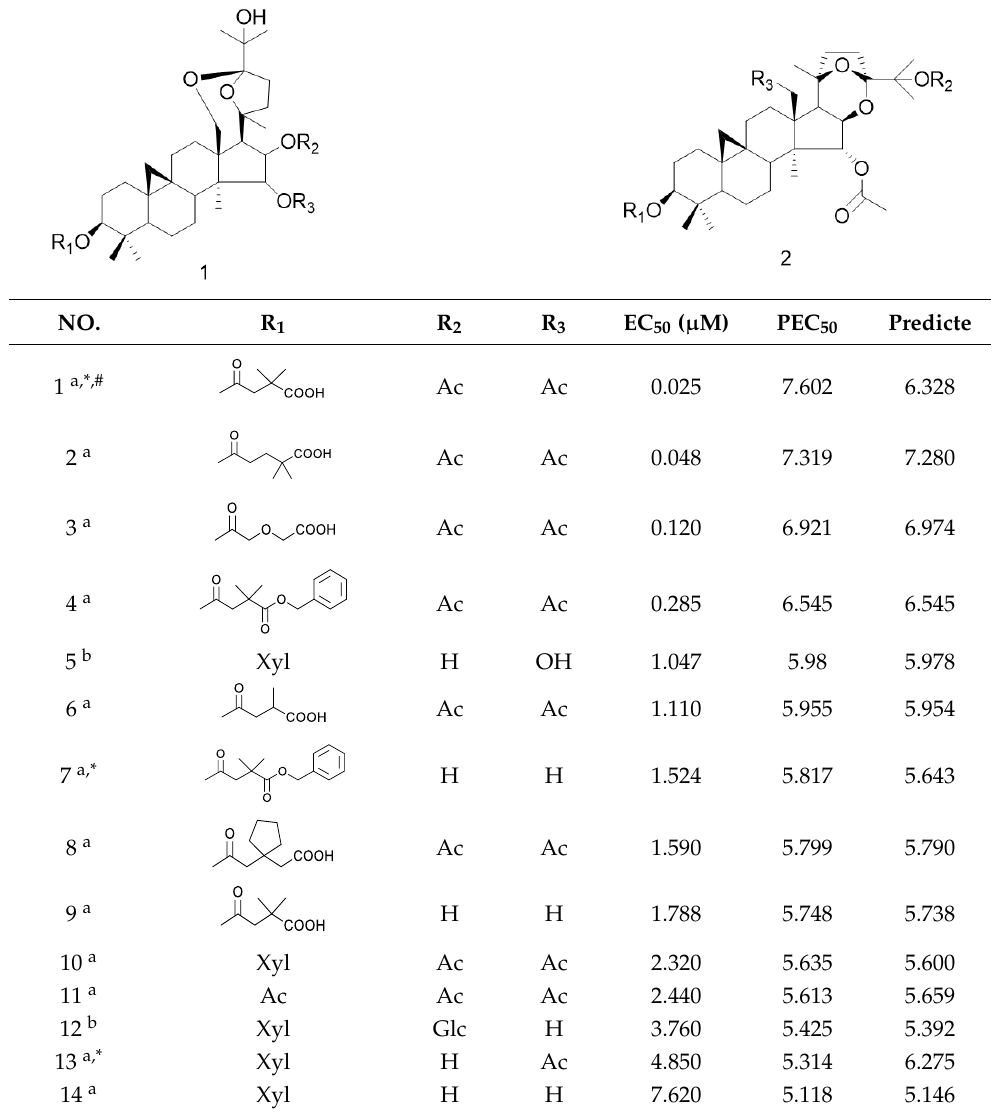
Table 2. Structures, EC 50 values of the actual and predicted by the best model.